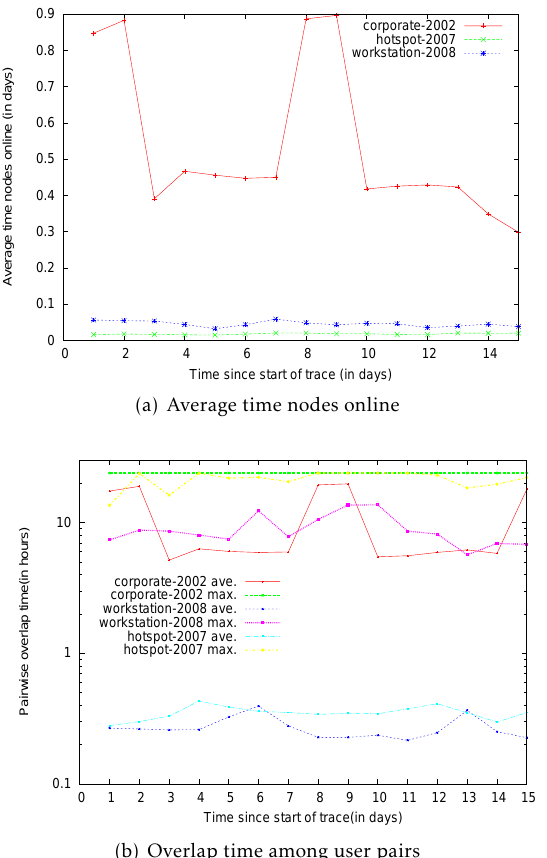
Figure 11. Availability parameters that affect the lag metrics